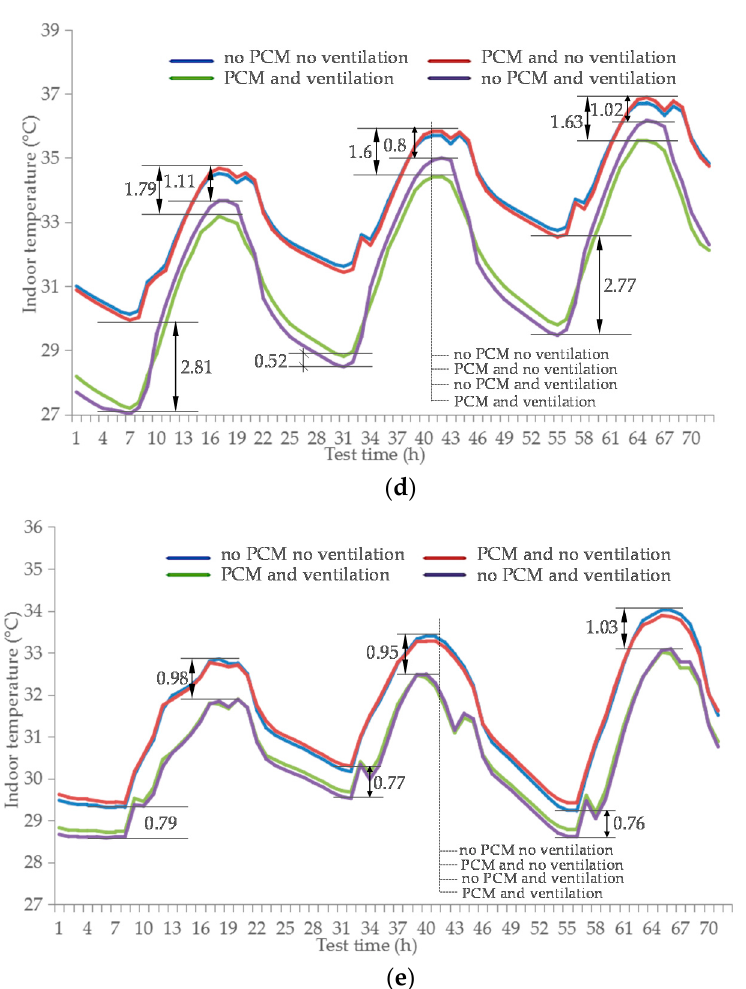
Figure 5. Indoor temperature fluctuations of building models, ( a ) Zhengzhou; ( b ) Kunming; ( c ) Shenyang; ( d ) Changsha; ( e ) Hong Kong (Ventilating 1 ac/h from 8:00 to 18:00).